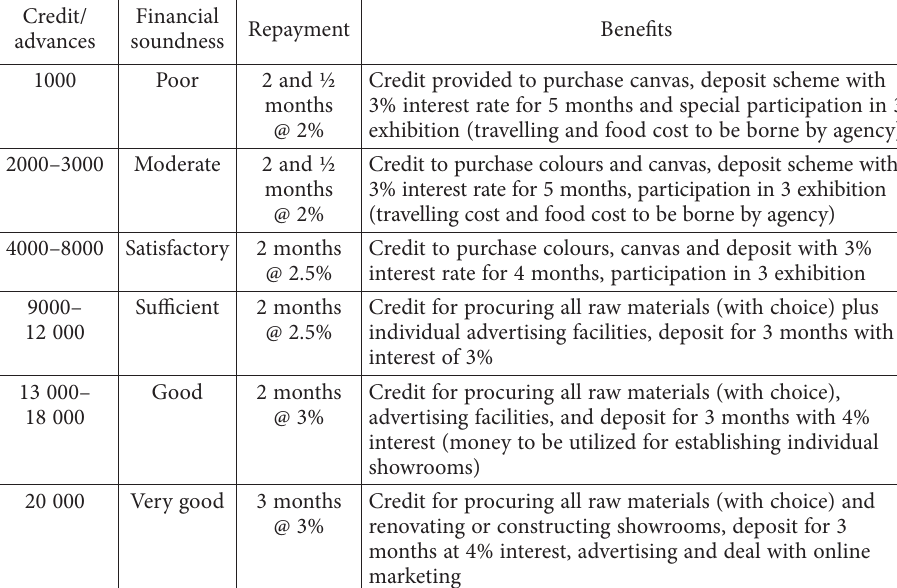
Table 6. Odisha chitrakara scheme (anticipated policy framework) (source: created by authors) Credit/